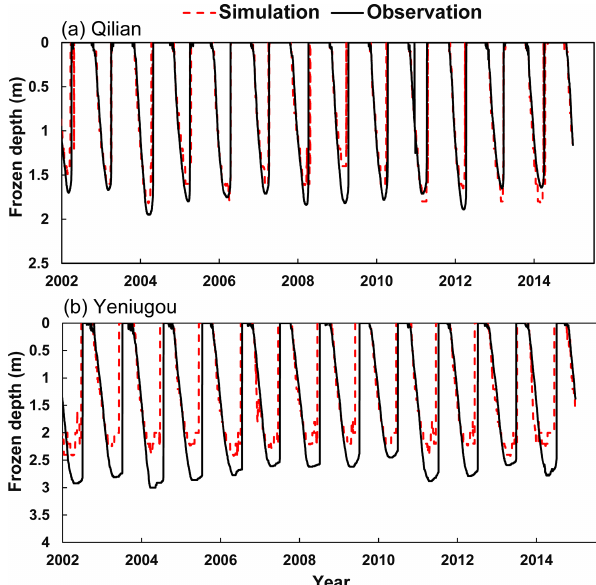
Figure 5. Comparison of the simulated and observed daily frozen depths during the period of 2002–2014 at (a) the Qilian station, and (b) the Yeniugou station.